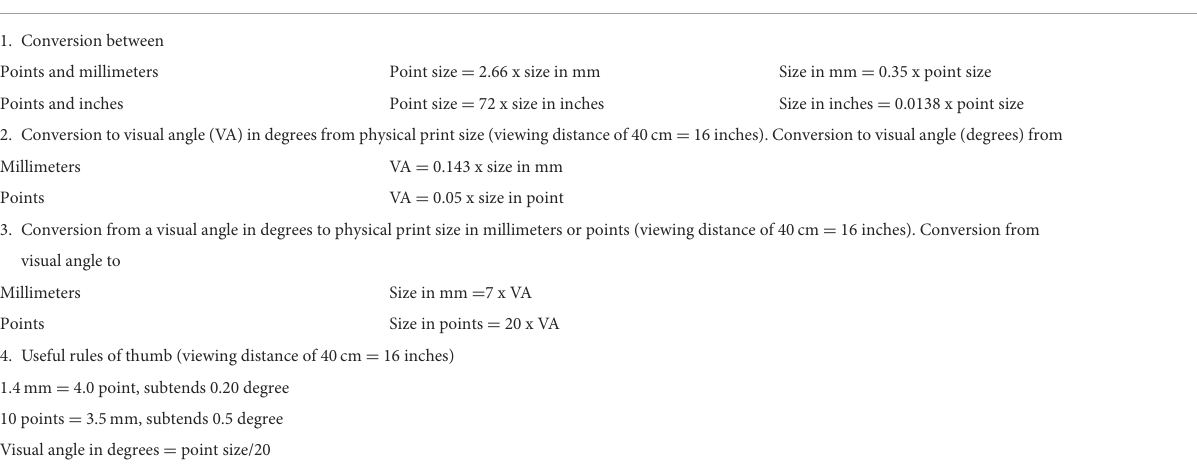
TABLE 10 Conversion between units (Legge and Bigelow,